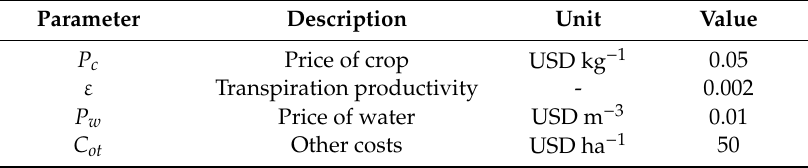
Table 3. Parameter values in the net income equation (Equation